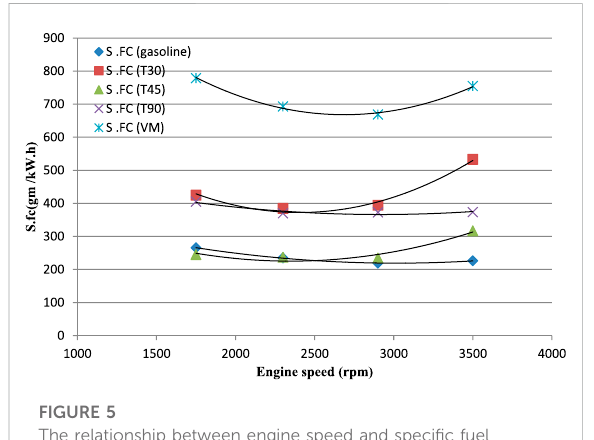
FIGURE 6 Speci fi cfuelconsumptionforalltypesofmixersattheengine speed of 2,900 – 3,500